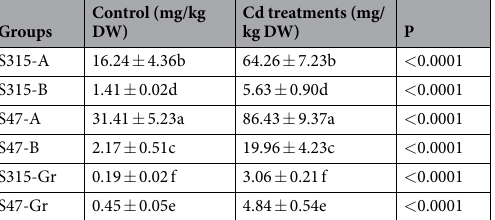
Table 1. The Cd concentration in different sites of the two cultivars before and after Cd treatments. S47 note high Cd-accumulative cultivar “ Shendao 47 ”, S315 notes low Cd-accumulative cultivar “ Shennong 315 ”, “A” indicates the first node, “B” indicates panicle node. Gr, grains. P value was tested using the unpaired t test. The different lowercases in the column notes the significant differences (p < 0.05) by the one-way ANOVA test.